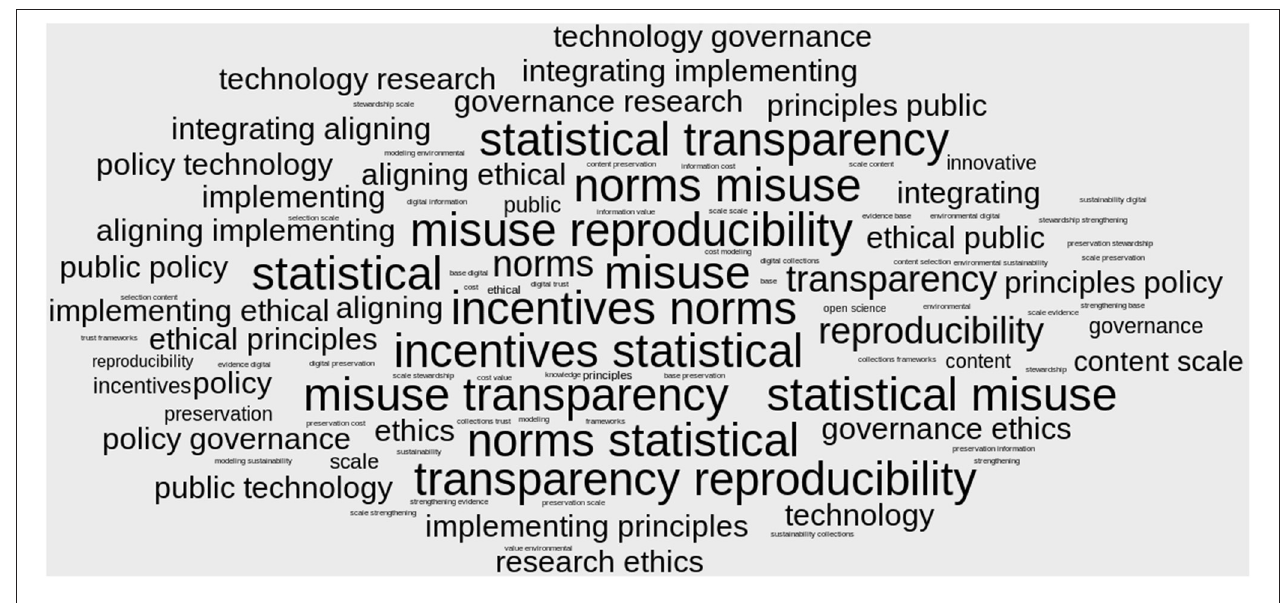
FIGURE 3 | Research